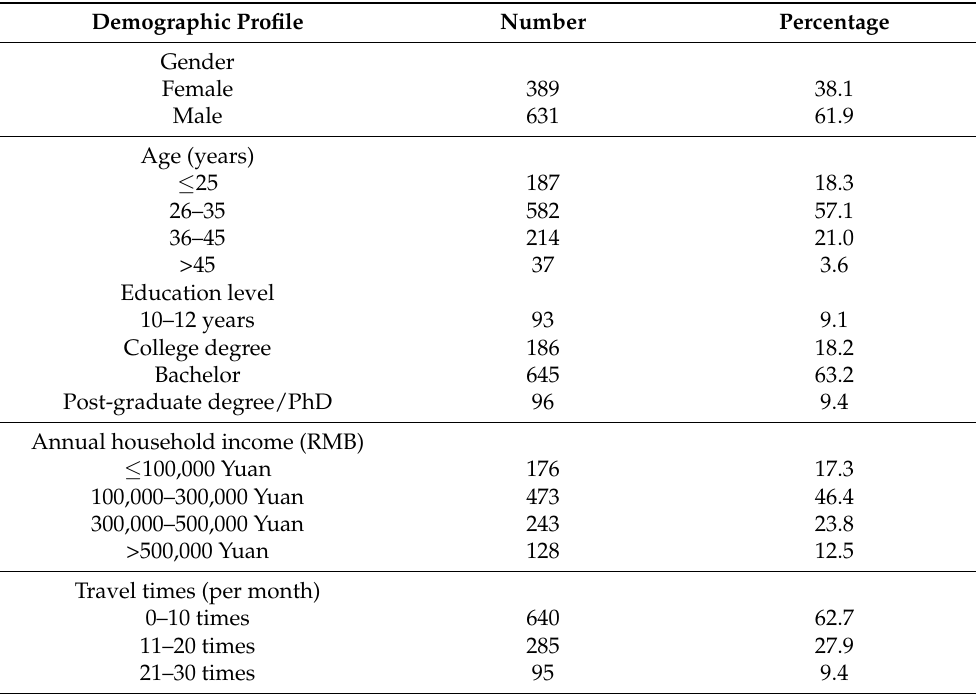
Table 1. Demographic characteristics of respondents (N =